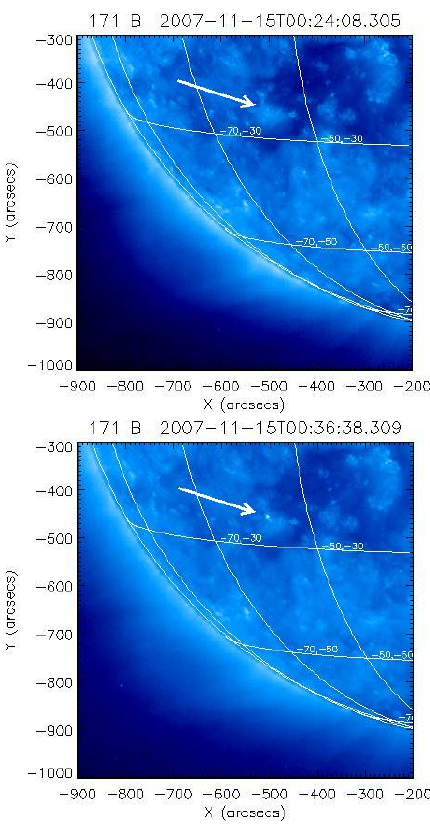
Fig. 6. Evolution of the bright point seen by STEREO B at 171 ˚A on 15 November 2007, for the event shown in Fig. 5.